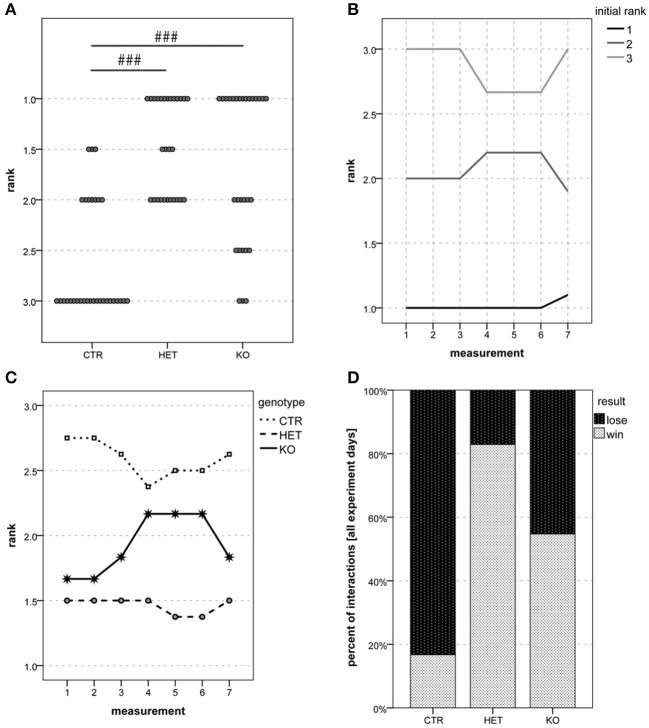
Social dominance: HET and KO mice are more dominant than CTR mice. In the tube test, 1 was the most common rank among both HET and KO mice, whereas 3 was the most common rank among CTR mice (A). Ranks remained very stable over time. (B) shows the development of the mean rank over time for three groups of mice based on their rank reached in the first test, whereas (C) shows the development of the mean rank per genotype over time. Of all their interactions, HET, KO and CTR mice won 82.9, 54.7, and 16.7%, respectively (D). (n = 5 CTR, 4 HET, 5 KO). (###p < 0.001).